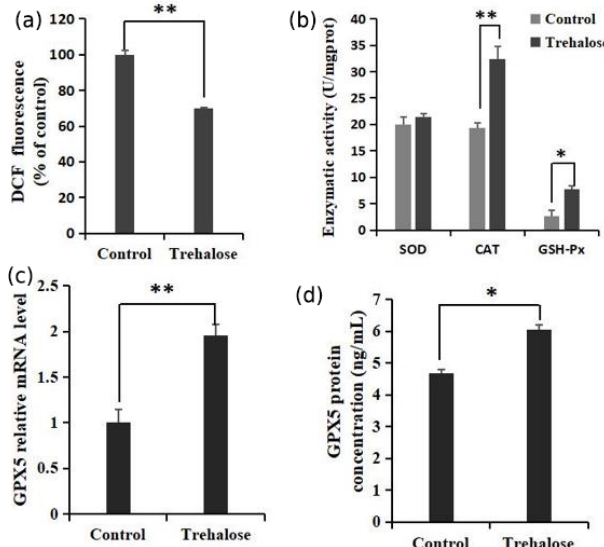
Figure 5. Effects of trehalose on ROS and antioxidant enzymes in sheep EECs. (a) The EECs were loaded with DCFH-DA (10µM) to capture the ROS-generated fluorescence after trehalose (100mM) pretreatment for 24h. The DCF fluorescence is expressed as % of control. (b) Activities of SOD, CAT, and GSH-Px in EECs treated with trehalose (100mM). (c) The expression of GPX5 mRNA was detected by qRT-PCR. (d) The expression of GPX5 protein was de- tected by ELISA. Control was EECs with 0mM trehalose treatment. * P < 0 . 05 and ** P < 0 . 01